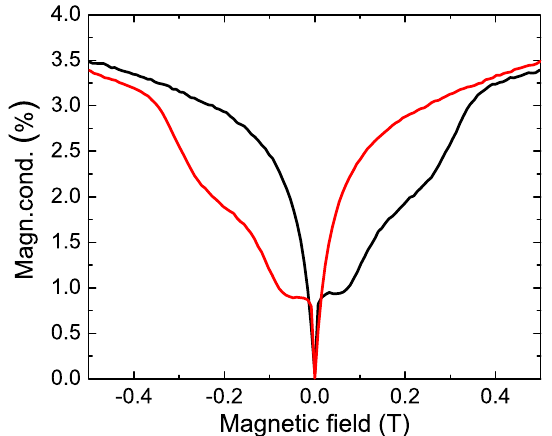
FIG. 6. Magnetoconductivity of devices with an electrically isolated ferromagnetic layer. The device structure consists of a ferromagnetic bottom electrode, a 12-nm SiO 2 layer, a 13-nm Pt layer, a 20-nm PEDOT layer, a 40-nm Alq 3 , a Ca layer, and an Al layer. The domain structure of this ferromagnetic electrode is similar to that employed in the device reported in Fig.